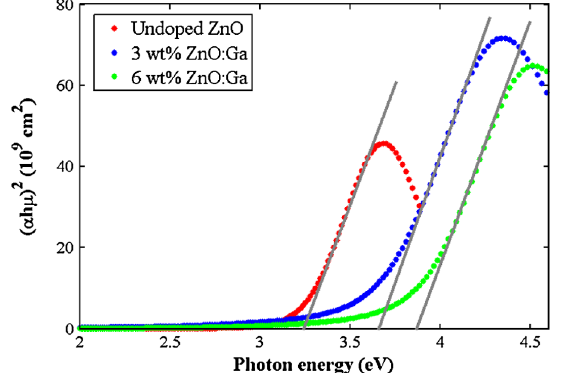
FIG. 5 (color online). Square of the absorption coefficient as a function of photon energy for ZnO, 3 wt% GZO and 6 wt% GZO thin films. E proportional to ð α ℏ ω Þ 2 is calculated by fitting g linear line to spectra E (Undoped ZnO):3.25 eV, E g GZO):3.66 eV and E (6 wt% GZO):3.25 g